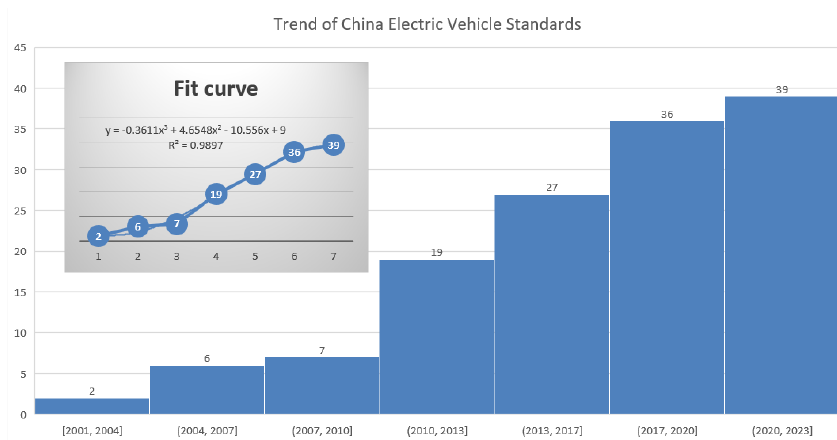
Figure 2. The published trend of China electric vehicle standards.